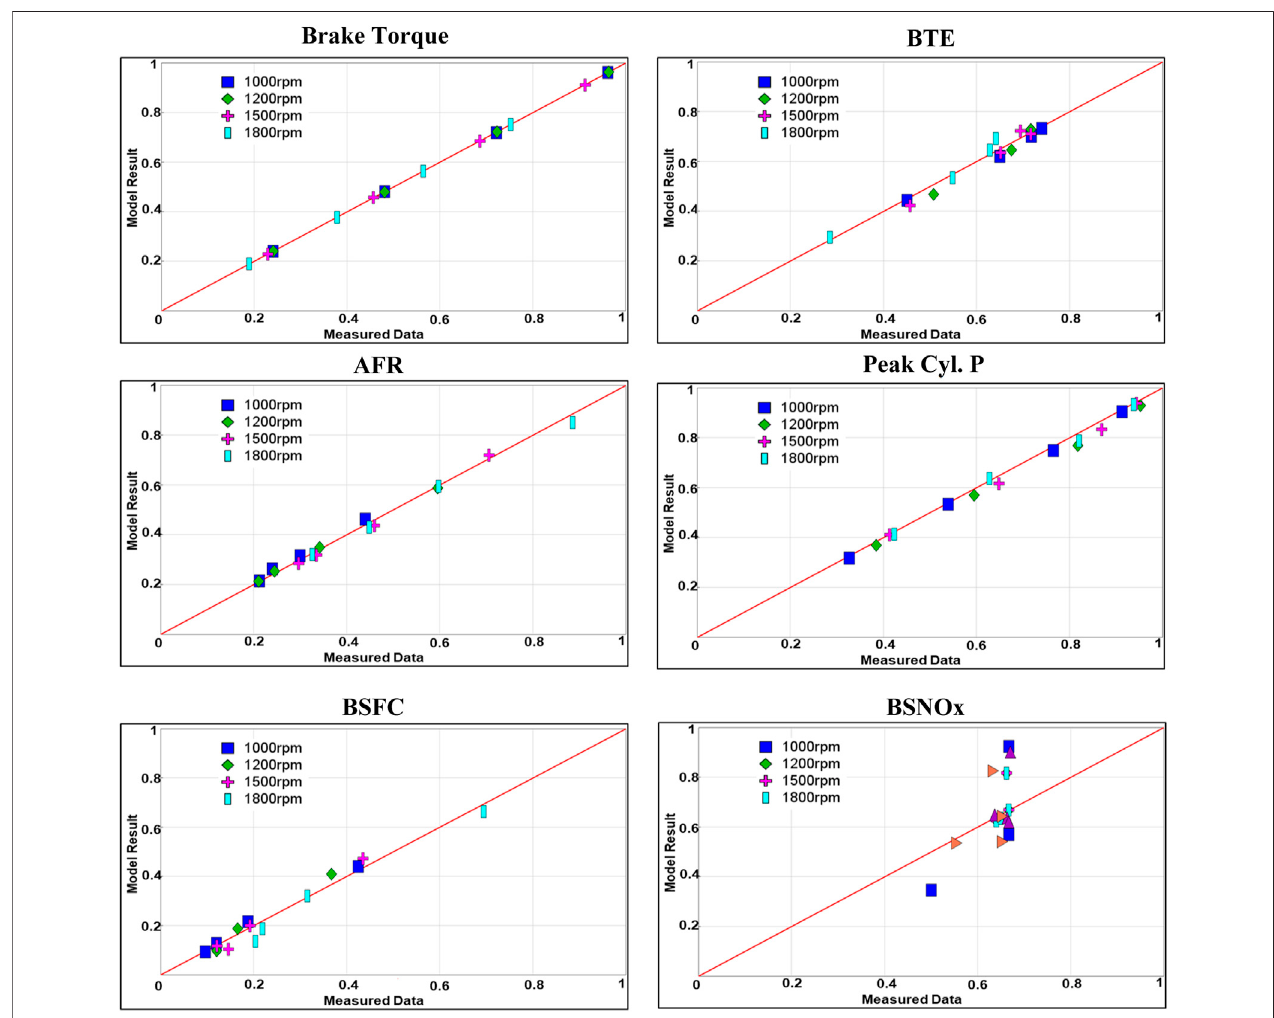
FIGURE 15 | GT model prediction comparison with measured data for key engine parameters.